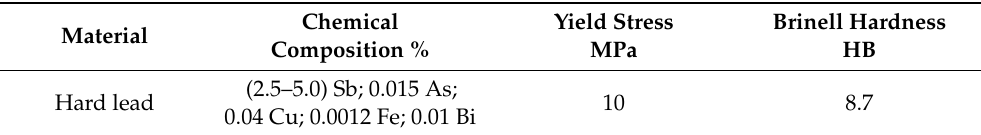
Table 2. Some features of materials used in the